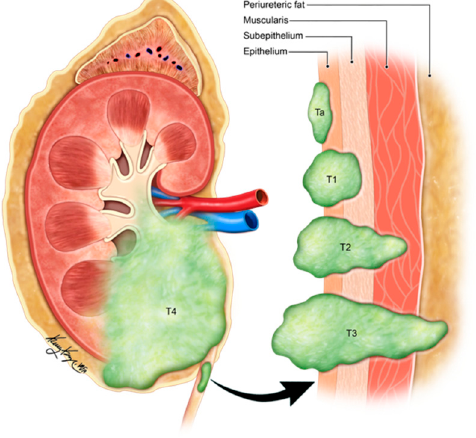
Table 10. Differential diagnosis of small-cell urethral NEC [124,125,128].